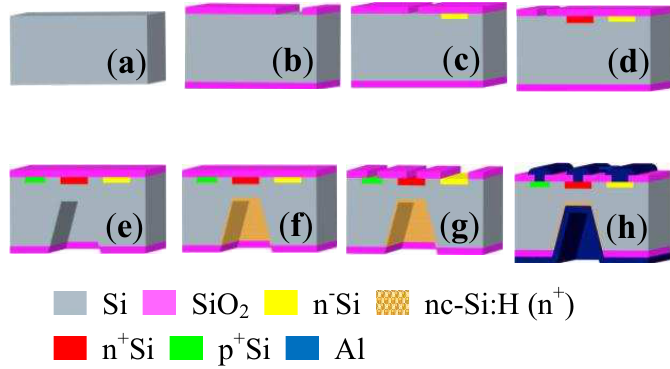
Figure 4. Main fabrication process of the integrated chip: ( a ) Cleaning wafer; ( b ) First photolithography; ( c ) Form the collector load resistor and second photolithography; ( d ) Making the collector and third photolithography; ( e ) Fabricating the base region and fourth photolithography; ( f ) Fabricating the